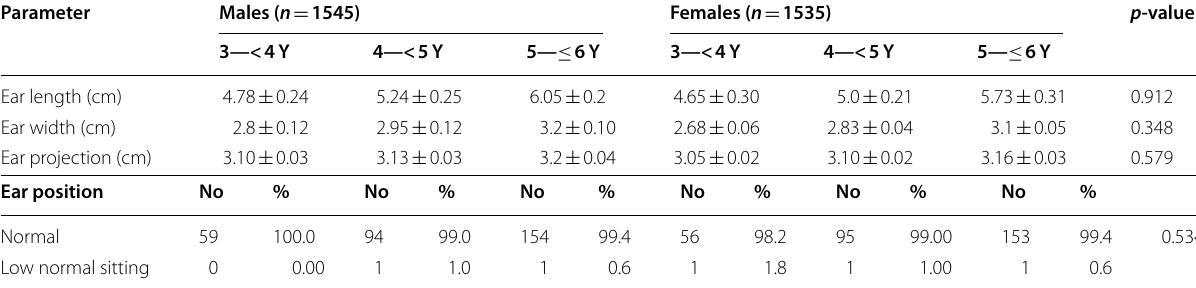
All values are expressed as mean